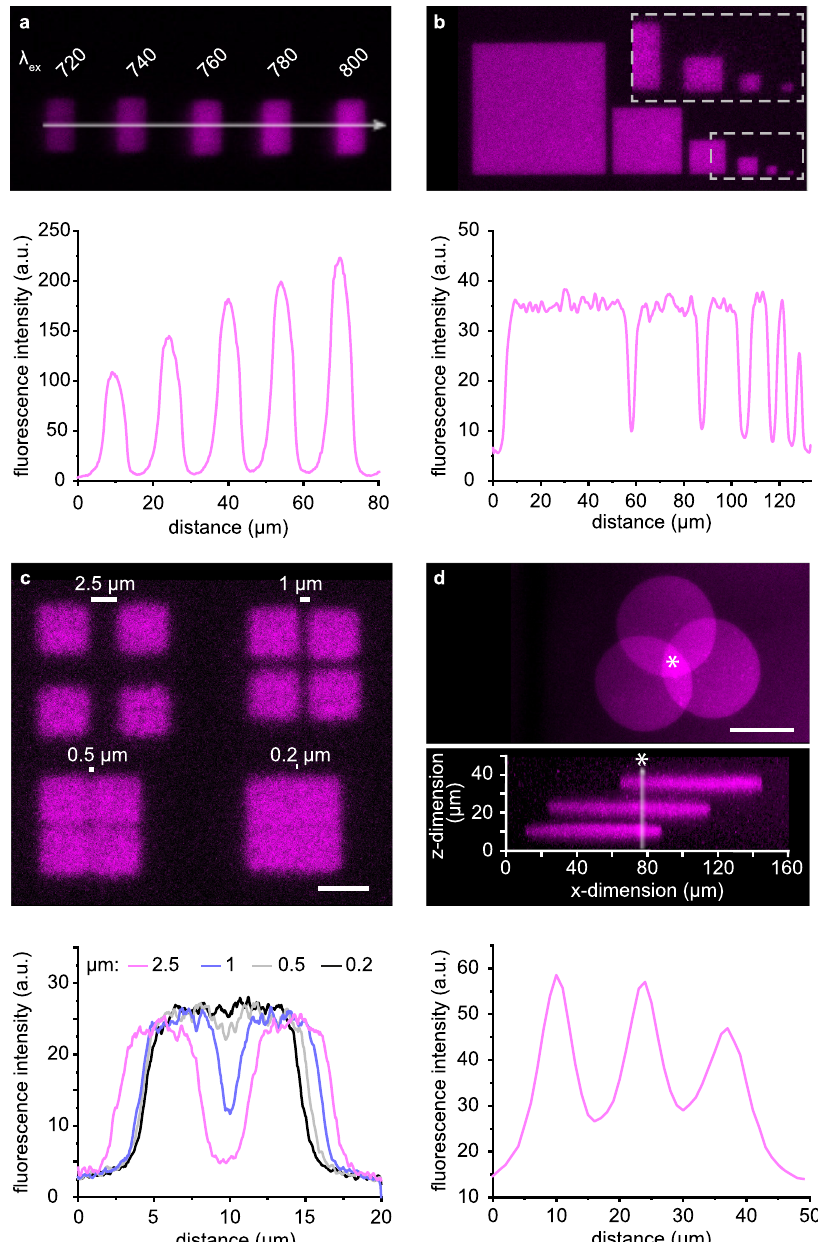
Fig. 4 In-gel photoevolution of TPA- tris NTA under two-photon excitation. a TPA- tris NTA functionalized hydrogel was activated with wavelengths from λ = 720 – 800 nm at 5 mW. Intensity pro fi les through the sum of z slices of immobilized AF647-POI showed the best photoactivation at 800 nm. For ex technical reasons, wavelengths higher than 800 nm are not applicable. b Assignment of the size limit for photostructuring in x/y dimension by writing six quadratic ROIs of decreasing size (50, 25, 12, 6, 3, and 2 µ m) into the gel. Intensity pro fi les of the ROIs demonstrated constant fl uorescence intensities heights in all ROIs except for the 2 µ m-ROI. c Determination of the resolution limit via two-photon structuring of four individual diffraction-limited squares in x/y direction. Spots separated by 1 µ m or more can be clearly distinguished by CLSM imaging, which is also re fl ected in the intensity pro fi le. Scale bar: 5 µ m. d 3D POI network constructed by two-photon activation of TPA- tris NTA. Three circular spots were written in different z layers to investigate the z resolution. Intensity pro fi les of AF647-POI in z direction showed spatially localized photoactivation with clearly distinguishable edges of the three written ROIs. a.u. corresponds to arbitrary units. Scale bar: 50 µ